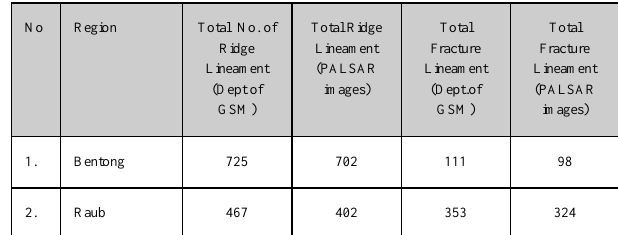
Table 1: Total number of lineaments from Maps Produced by the Department of Mineral & Geoscience (GSM).